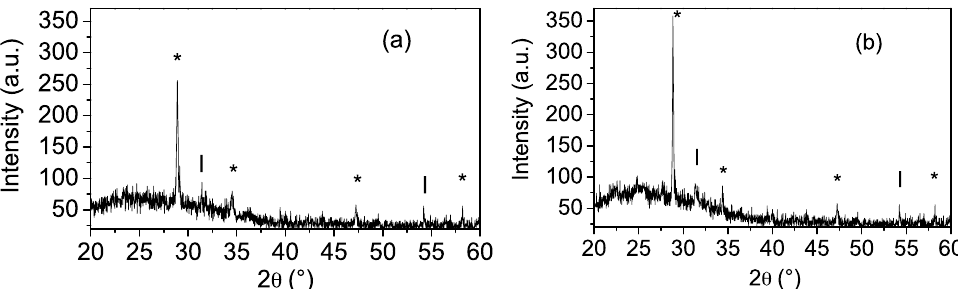
Figure 4. X-ray diffraction patterns of Zn(O;OH)S-thin film thickness as a function of the number of the layers. ( a ) Zn(O;OH)S coatings three layers. ( b ) Zn(O;OH)S coatings four layers. Inside figure: (*) The signal could be assigned to Wurtzite and/or Zincblende structure. ( l ) The signal could be assigned to Zn(OH) 2 structure.